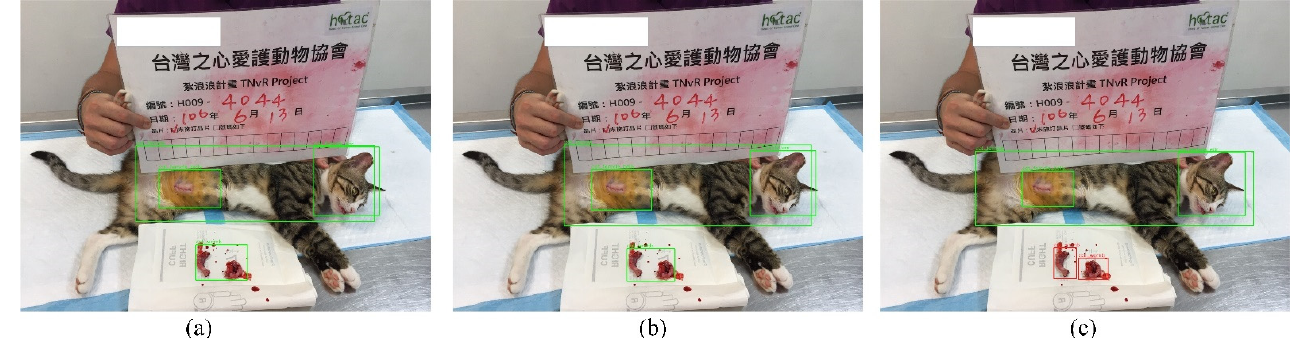
Figure 8. Pictures of the Yolov3-Tiny ( a ), Yolov3 ( b ) and Yolov4 ′ s ( c ) detection performance for female cat. Table 5. Detection performance for female cat.